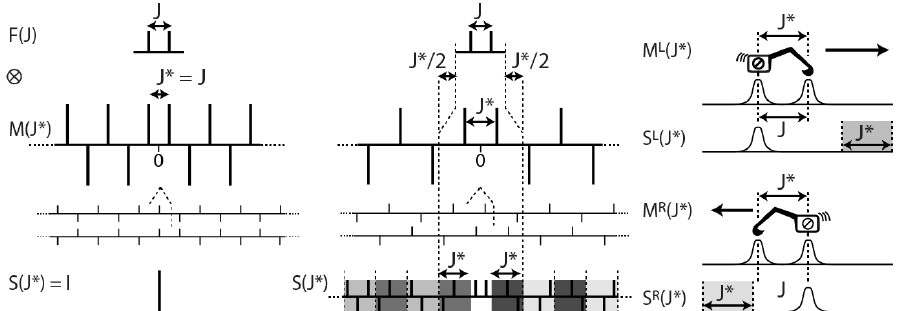
Figure 2. (Left) The function M ( J ∗ ) cancels the doublet of a weakly coupled partner with a spin 1 / 2 when J ∗ = J . (Middle left) Duplicating M and shifting one copy by the distance J indeed cancels all except the central peak, resulting in the expected simplification (bottom left). (Centre) When J ∗ (cid:54)= J , the convolution product results in the complex set of δ functions S (middle bottom). (Right) Illustration of the algorithm starting at one side of the spectrum. It can be seen as walking from one boundary of the multiplet, in the manner of an integrator, and subtracting, at the distance J ∗ , the amplitude measure